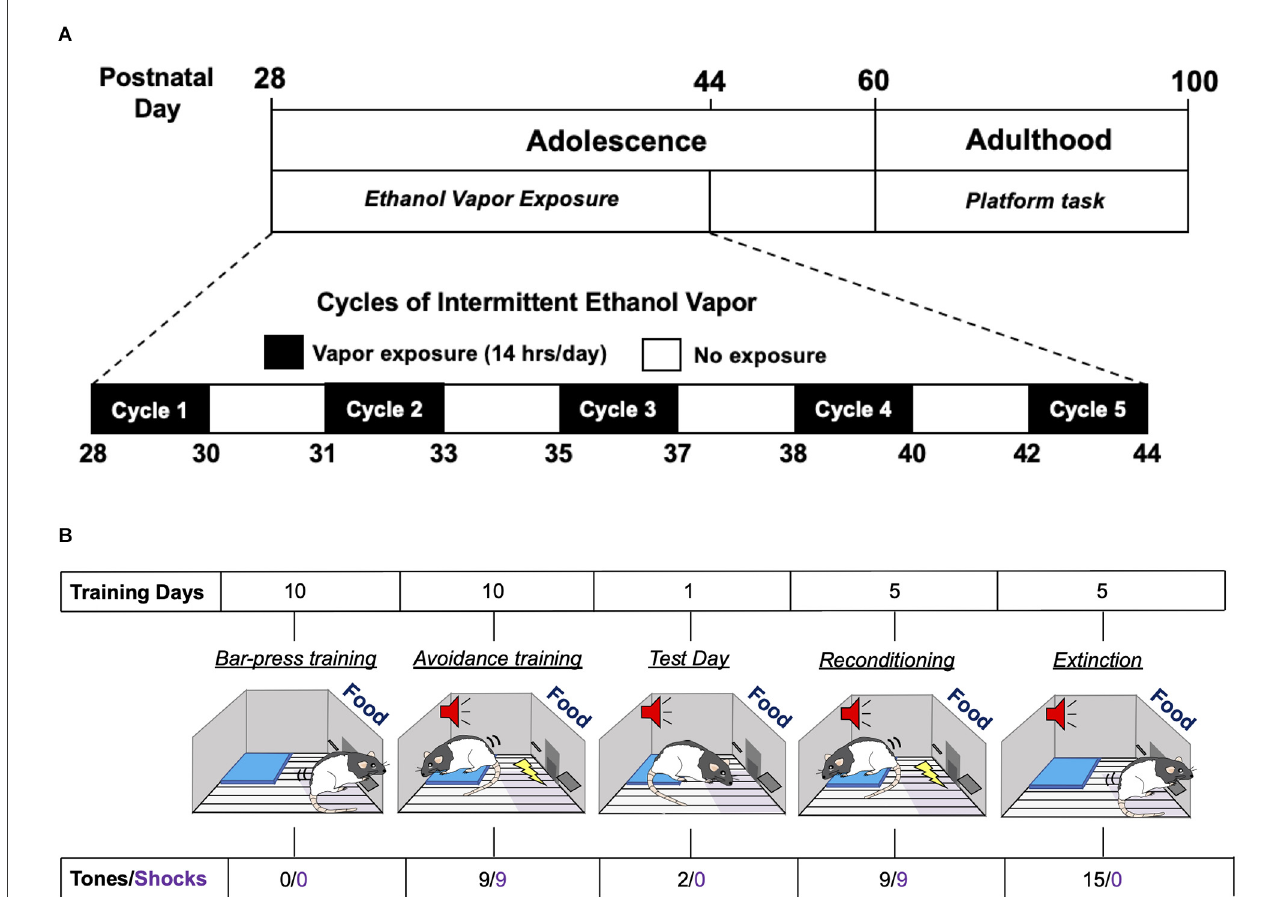
FIGURE1 Experimental time-line of adolescent intermittent ethanol exposure and the platform-mediated avoidance task. (A) Schematic depiction of the daily sequence of adolescent intermittent ethanol (AIE) exposure by vapor inhalation followed by platform-media avoidance testing in adulthood. (B) Schematic depiction of the sequence for the different phases of the platform-mediated avoidance task for assessment of approach-avoidance